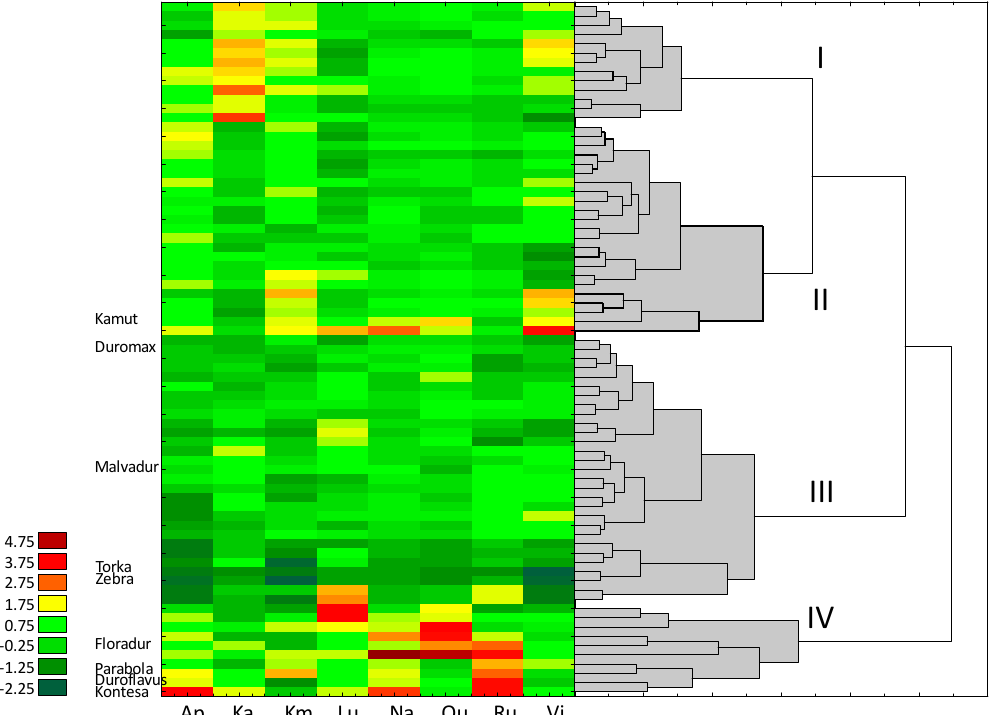
Figure 6. The results of the cluster analysis investigating the concentrations of eight flavonoids in the grain of the analyzed T. polonicum accessions versus four durum wheat cultivars (Floradur, Duroflavus, Malvadur, and Duromax), four bread wheat cultivars (Kontesa, Parabola, Torka, and Zebra), and Kamut ® wheat. Ap—apigenin, Ka—catechin, Km—kaempferol, Lu—luteolin, Na—